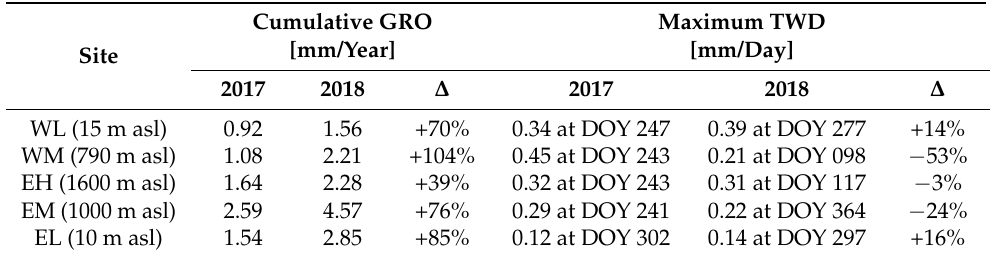
Table 1. Site averages of radial cumulative irreversible growth (GRO) and tree water deficit (TWD). Cumulative Site